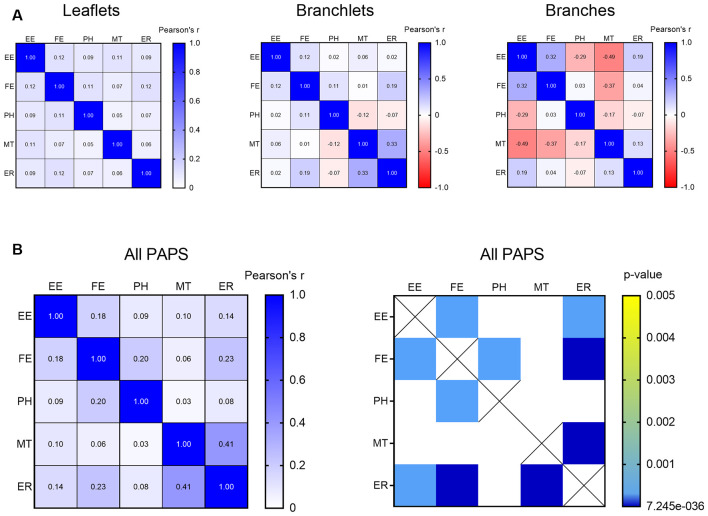
(A) Correlation matrix indicating the strength of the correlation between all the described organelles in leaflets, branchlets, and branches separately. (B) Correlation matrix indicating strength (left) and significance (right) of the correlation between all the described organelles in all the PAPs pooled together. Only significant correlations after Bonferroni’s correction for multiple comparisons are displayed. Empty endosomes (EE), full endosomes (FE), phagosome (PH), mitochondria (MT), and ER cisternae (ER) for all panels.